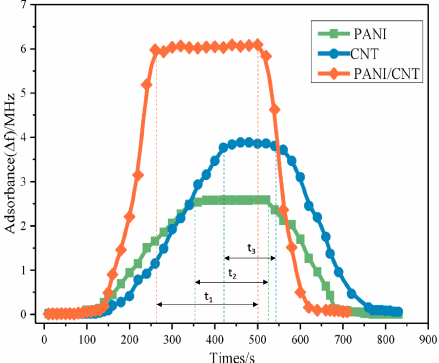
Figure 7. Unsynchronized Response and Recovery